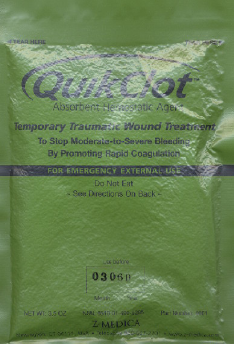
Figure 4: Ground up zeolite sold as Quick